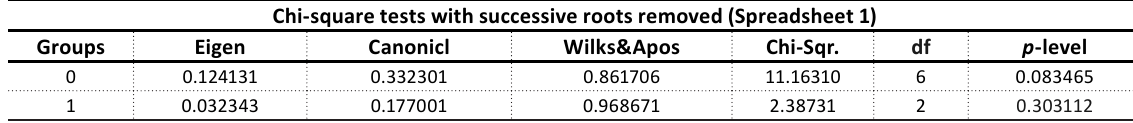
Table D1. Test results of a discriminant model using criterion